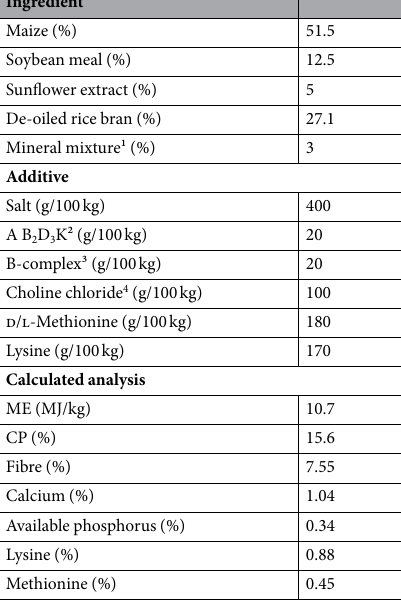
Table 1. Composition of non-antibiotic basal diets. ¹Contained: Ca, 32%; P, 6%; Mn, 0.44%; Zn, 0.33%; I, 150 ppm; Fe, 2000 ppm; Cu, 250 ppm; Se, 45 ppm. ²Contained per gram: A, 82,500 IU; D3, 12000 IU; B 2 , 50 mg; K, 10 mg. ³Contained per gram: B 1 , 4 mg; B 6 , 8 mg; B 12 , 40 μ g; E, 20 mg; niacin, 60 mg; calcium pantothenate, 12.5 mg. 4 Contained 60% choline chloride. 5 Contained 78% l-lysine